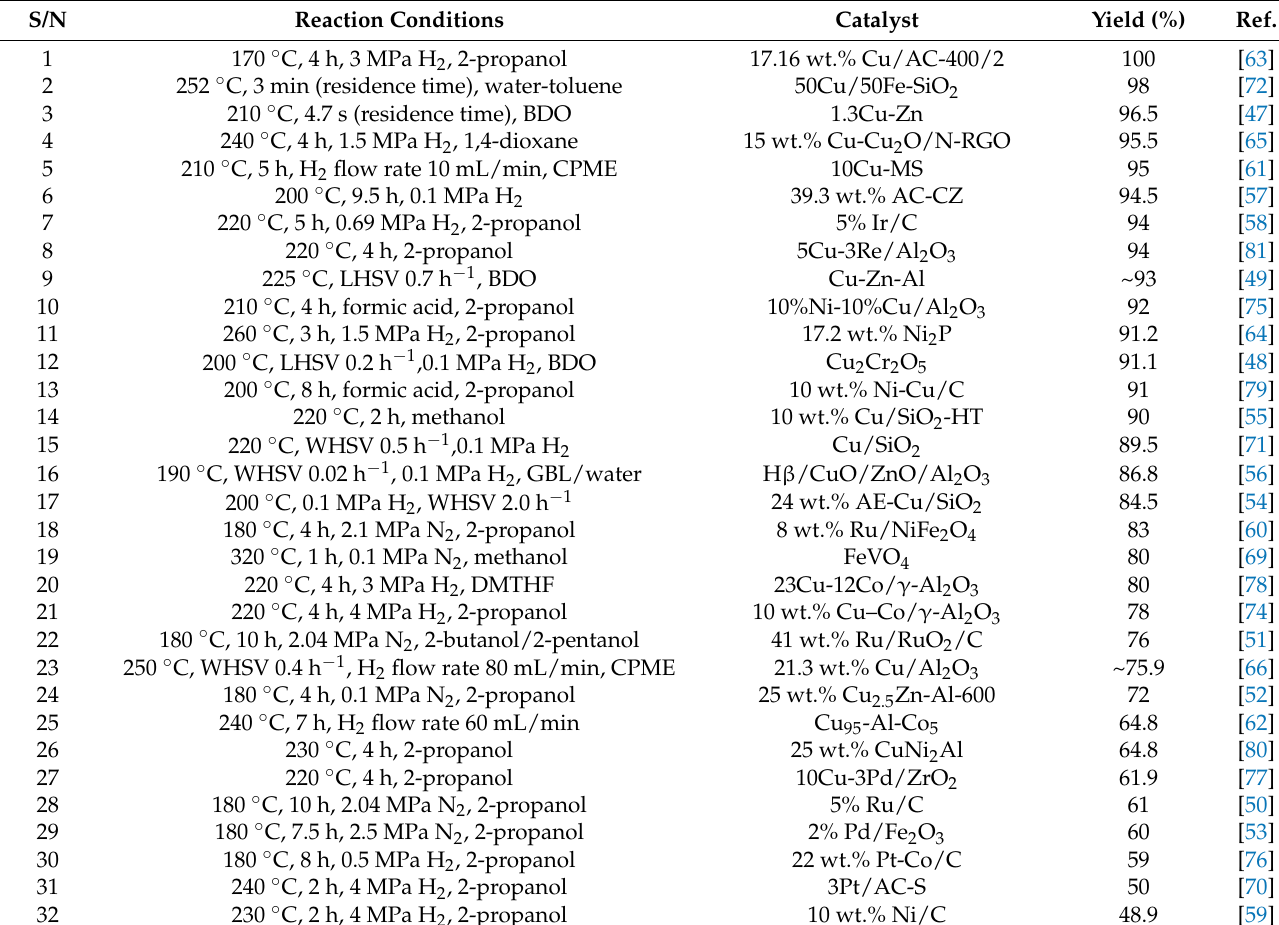
Table 1. Synthesis of 2MeF from